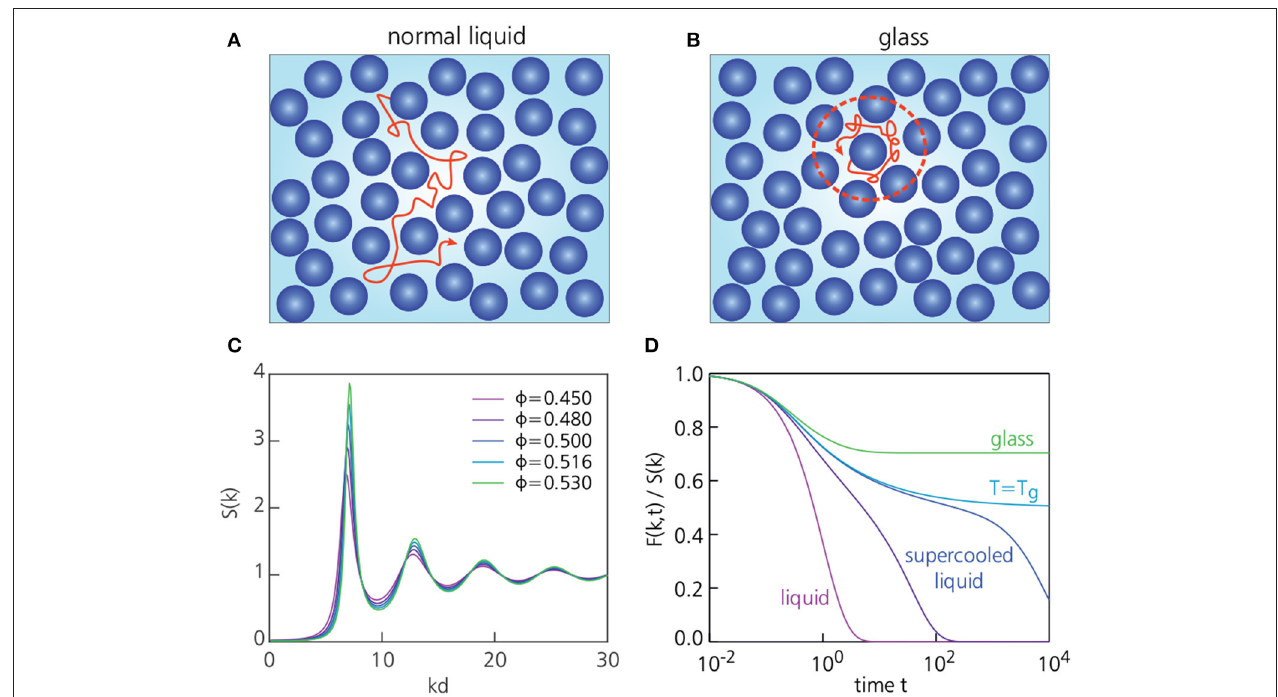
FIGURE 3 | Schematic picture of the structure and dynamics in a normal liquid, supercooled liquid, and glass. (A,B) depict a typical trajectory of a particle in the normal liquid phase and glassy phase, respectively. In the glassy state, particles become trapped in a cage formed by their neighbors. The dashed red line indicates the typical size of a cage, with a radius of approximately one particle diameter d . (C) Shows the static structure factors S ( k ) for a glass-forming system of hard spheres for several packing fractions φ , calculated using the Percus-Yevick approximation. The main peak position of S ( k ) corresponds to a wavenumber of approximately one inverse particle diameter, k ≈ 2 π/ d . Within MCT, the glass transition for this system takes place at φ c = 0.516 [24]. (D) Shows typical intermediate scattering functions F ( k , t ) as a function of time for k ≈ 2 π/ d . As the temperature is decreased or the packing fraction is increased, the system becomes more glassy and F ( k , t ) decays more